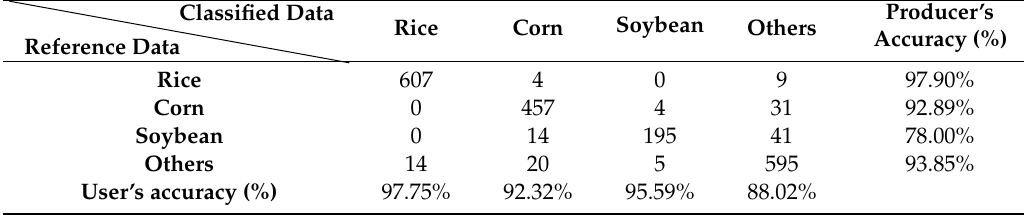
Table 6. Confusion matrix of crop layer without feature sorting and